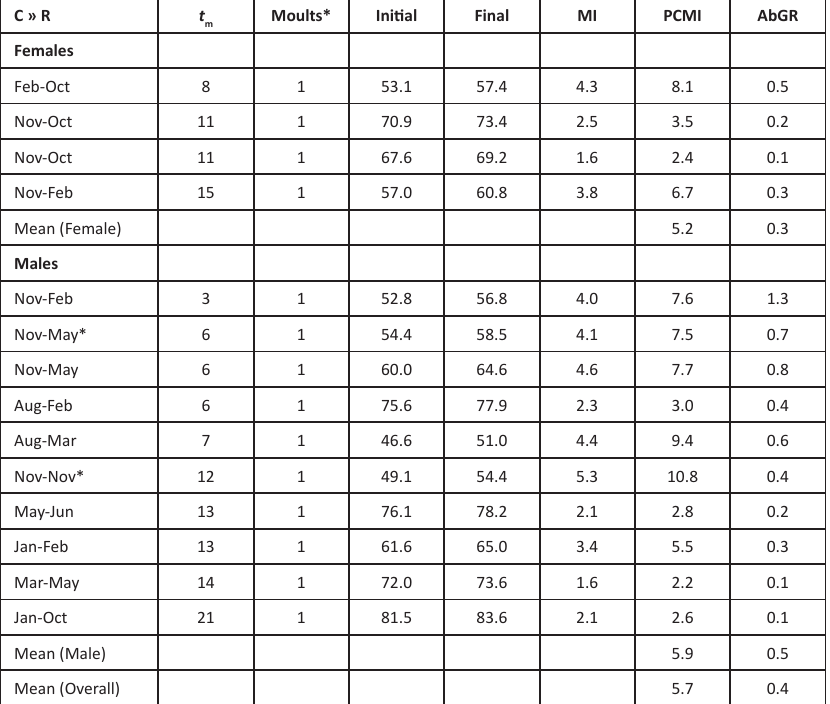
Table 2. Growth and moulting records for recaptured Euastacus sulcatus , from Brindle Ck, and determination of the PCMI (%) and AbGR (mm/month) for OCL. C»R, earliest and latest months of capture and recapture for each growth interval; t records; Moults*, estimated number of moults between records; Initial, OCL prior to moulting (mm); Final, OCL after moulting (mm); MI, moult increment (mm). Two entries marked * are for the same individual, which moulted twice during the study, and was recaptured and measured each